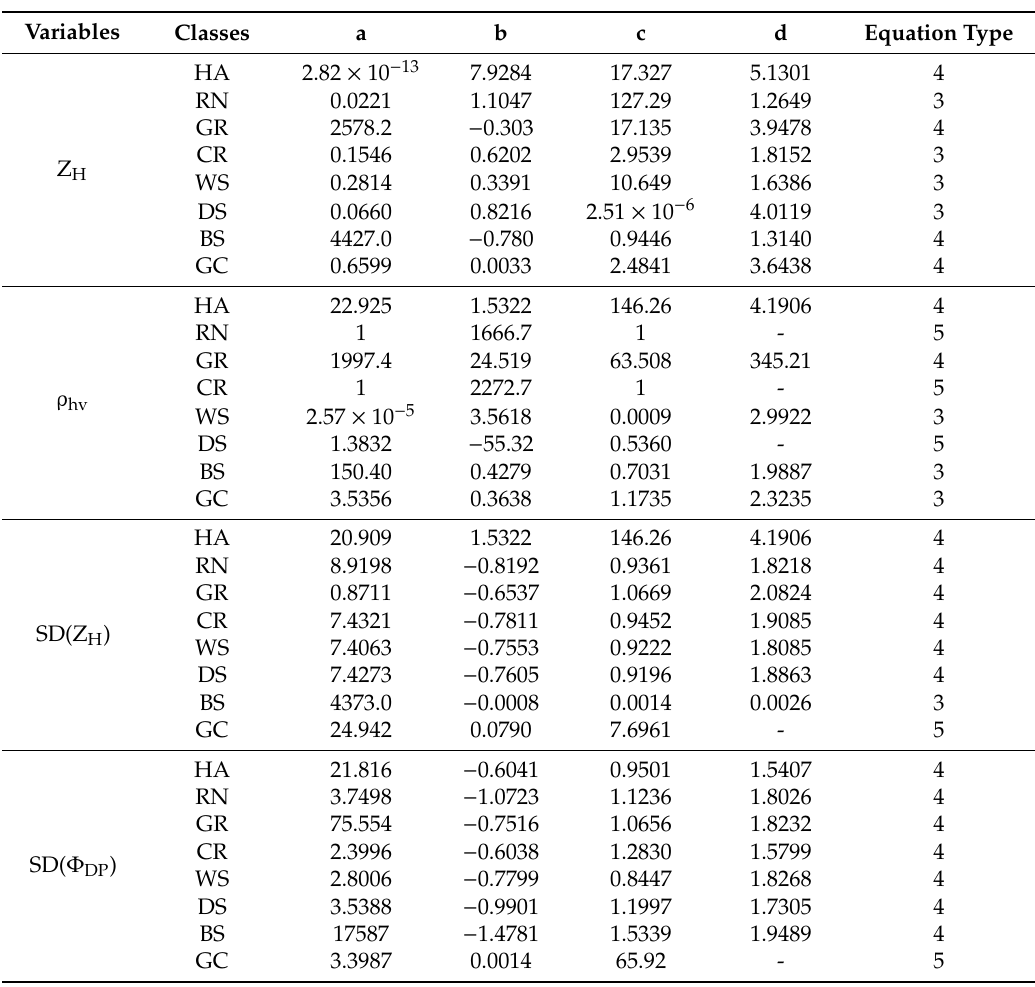
Table 1. Fitted function parameters of the likelihood conditional probability for four variables horizontal reflectivity (Z H ), the cross-correlation coe ffi cient ( ρ hv ), standard deviations of horizontal